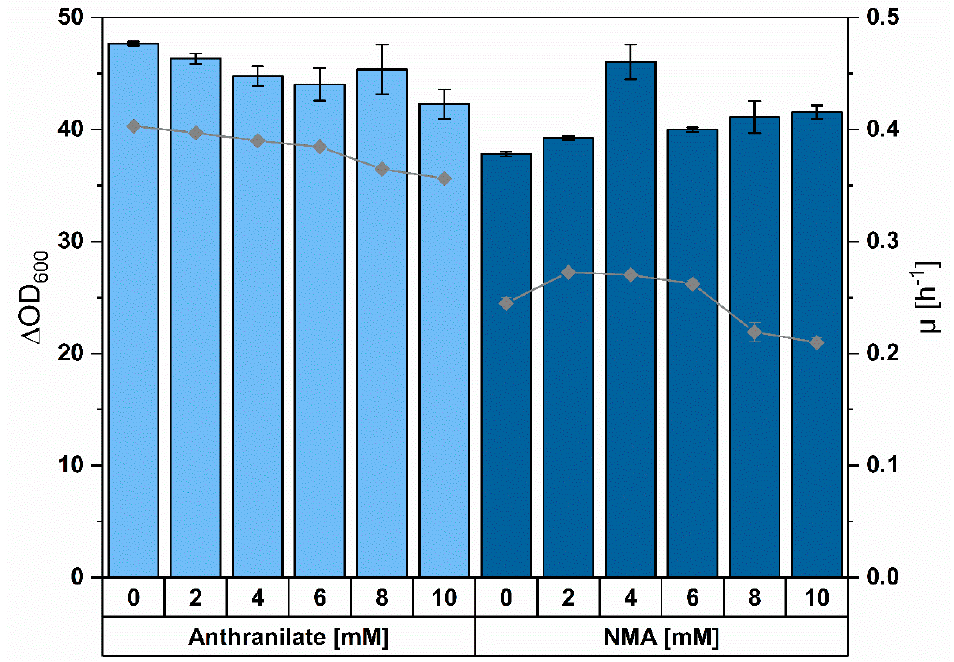
Figure 2. Effect of externally added NMA (bright blue) and anthranilate (dark blue) on biomass formation (columns) and specific growth rate (lines) of C. glutamicum strain ATCC13032. Each condition with NMA contained the same amount of methanol (1.65 M) in minimal media. Averages and standard deviation of triplicate cultivations are shown.